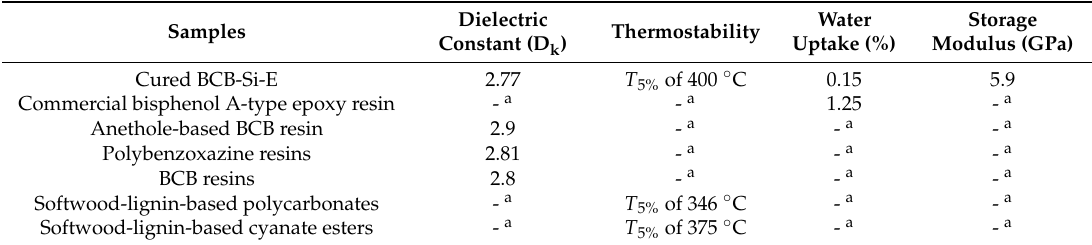
Table 3. Performance comparison of benzocyclobutene-silicone-eugenol resin (BCB-Si-E) with other commercial resins (Summarized from Reference